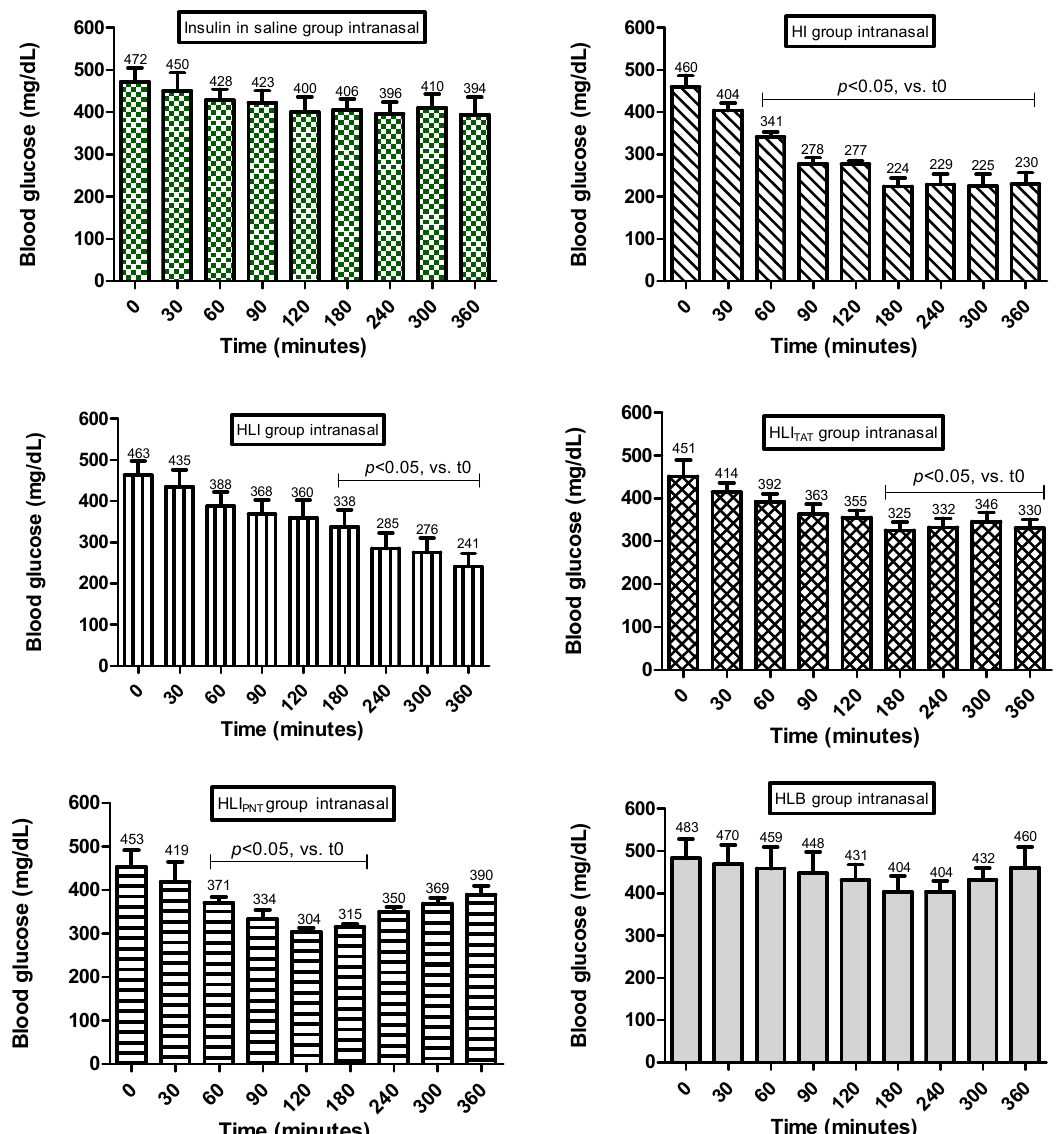
Figure 4. Glycemia levels (mg dL − 1 ) in diabetic rats after intranasal administration of insulin. Insulin dose administered by subcutaneous and intranasal: 2.0 IU insulin/formulation/animal. Maximum volume of intranasal instillation: 100 µ L divided into 25 µ L applications introduced alternately in each nostril. (i) Intranasal administration of saline (0.85% NaCl) (SS nasal ); (ii) subcutaneous administration of 2.0 IU insulin (Novolin R ® ) (INS sub ); (iii) intranasal administration of 2.0 IU insulin prepared in saline (INS nasal ); (iv) intranasal administration of HEC-based hydrogel containing 2.0 IU insulin (HI); (v) intranasal administration of HEC-based hydrogels containing 2.0 IU insulin-loaded liposomes (HLI); (vi) intranasal administration of HEC-based hydrogels containing 2.0 IU insulin-loaded liposomes functionalized with TAT (HLI TAT ); (vii) intranasal administration of HEC-based hydrogels containing 2.0 IU insulin-loaded liposomes functionalized with PNT (HLI PNT ); (viii) intranasal administration of HEC-based hydrogels containing blank liposome (HLB).